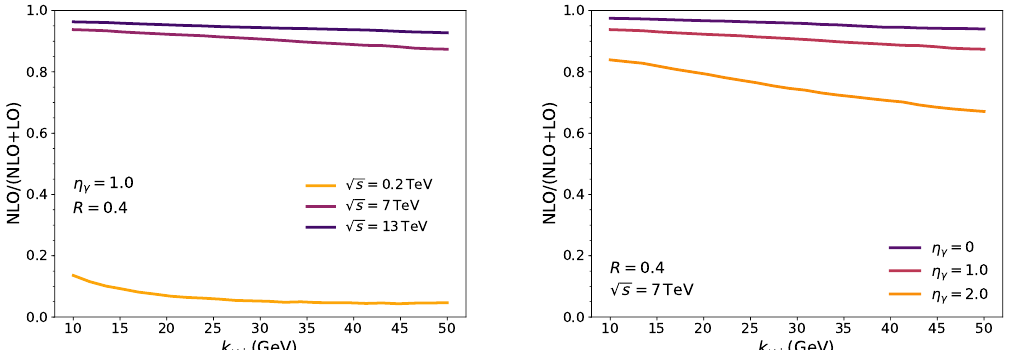
Figure 2. Fraction of the inclusive photon cross section from the NLO gg → q ¯ q γ channel relative to the total NLO+LO contribution, as a function of k γ ⊥ for the k ⊥ -factorized formula [4]. The left panel √ s = 0.2,7,13 TeV for η γ = 1.0. The right panel shows the shows the collision energy dependence at √ s = 7 TeV. In both cases, R = photon rapidity dependence at η γ = 0,1.0,2.0 for